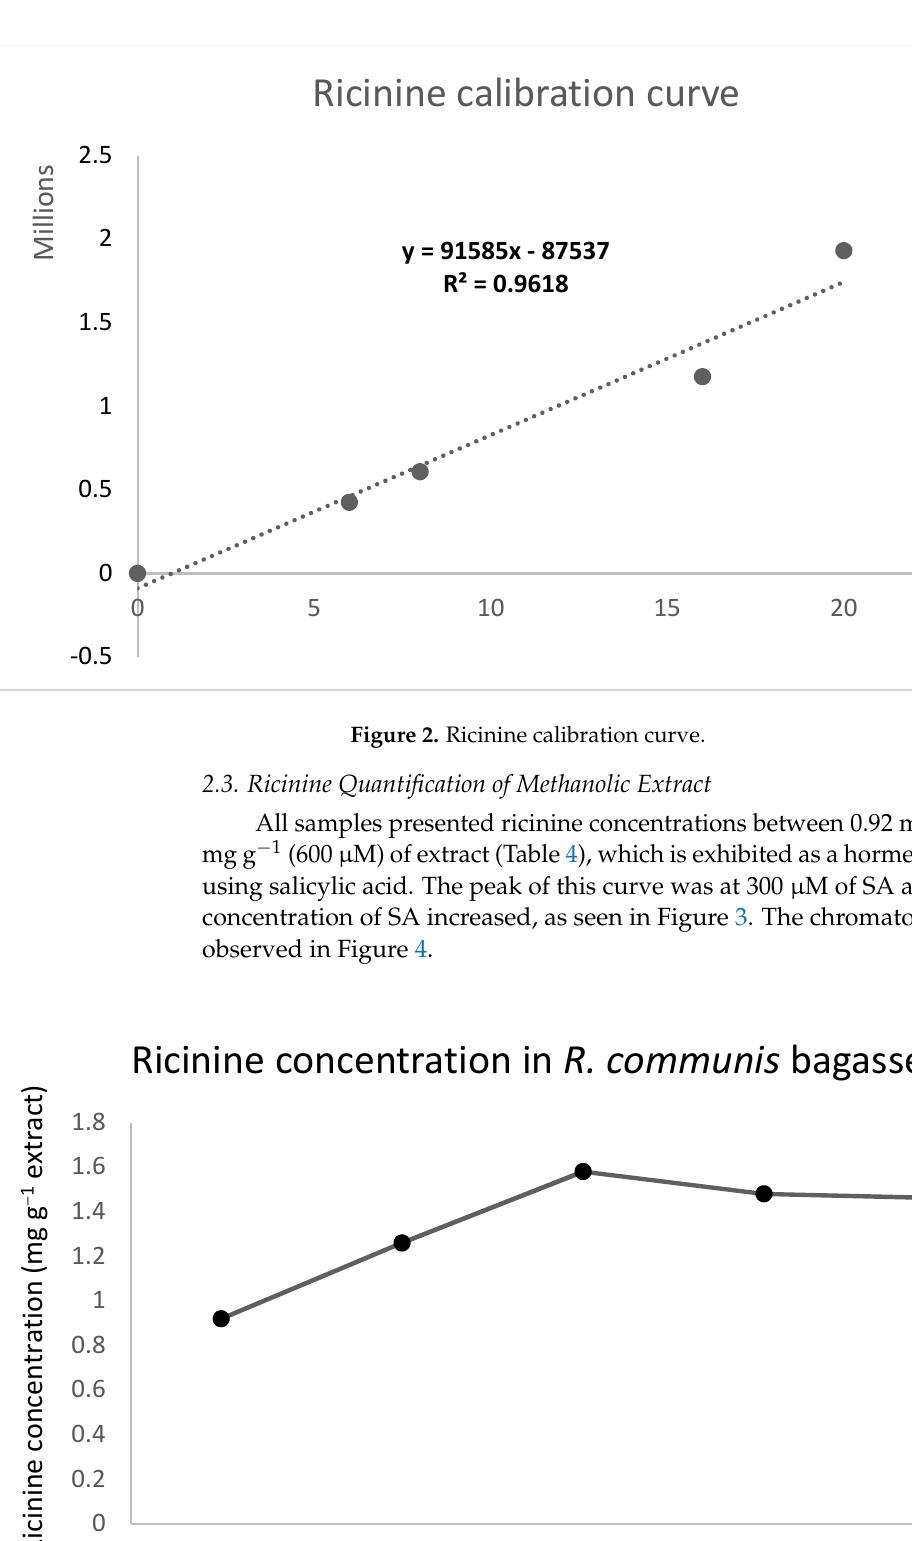
Figure 1. Chromatogram of ricinine standard and its absorption spectrum in UV–Vis.